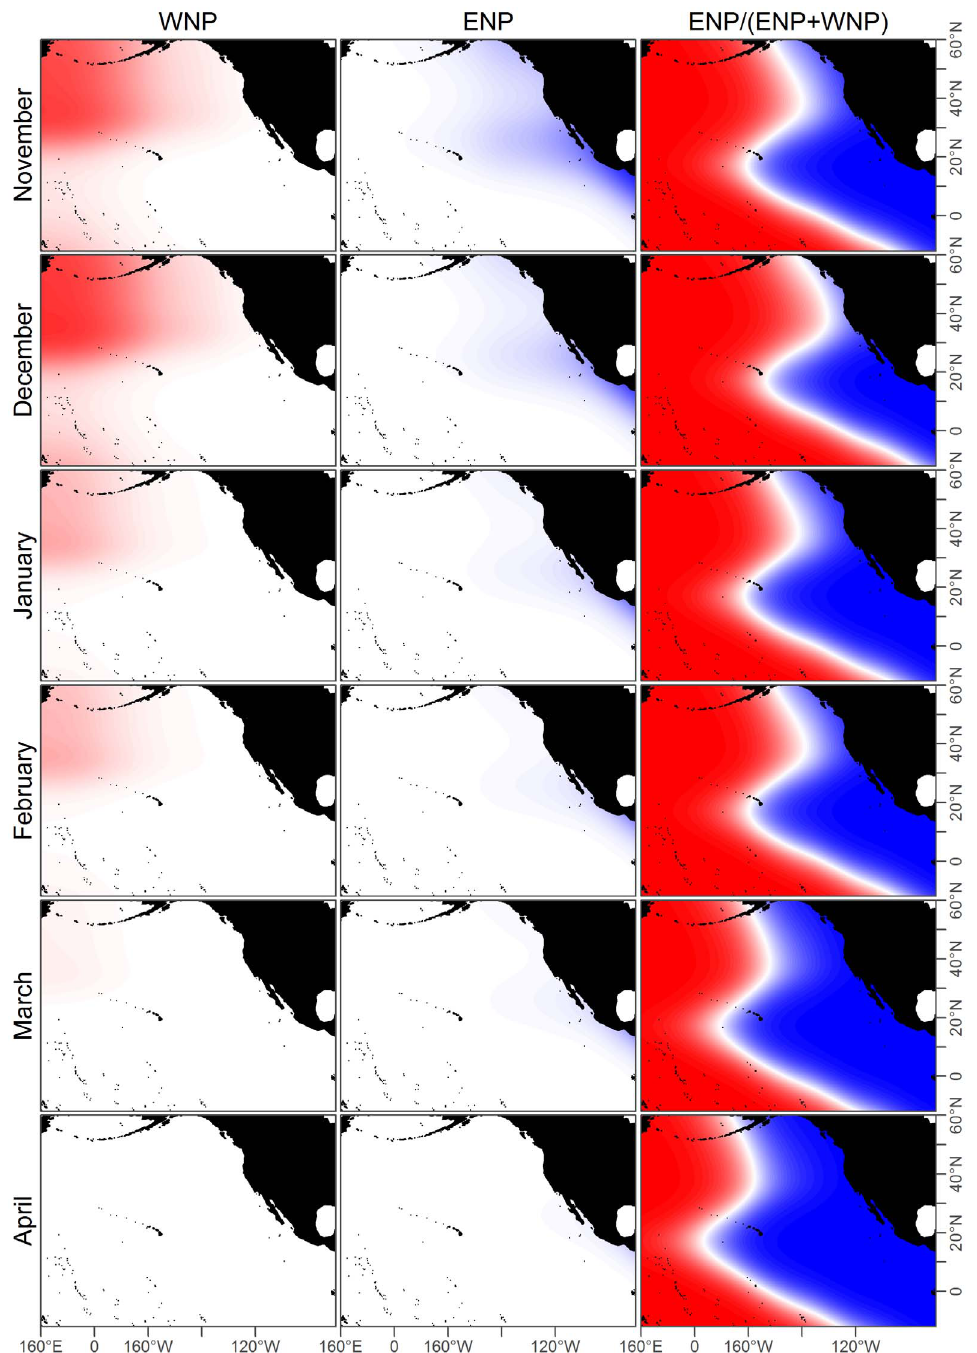
Figure 7. Fits for ENP acoustic, WNP acoustic, and base case prediction models for November-April. These models are fit to the acoustic data in Figures 4 and 5. The third column shows the base case prediction model which is the proportion of ENP to WNP calls, such that red areas correspond to predicted WNP occurrence and blue areas to ENP. The white line denotes where the model predicts an equal chance of observing an ENP or WNP blue